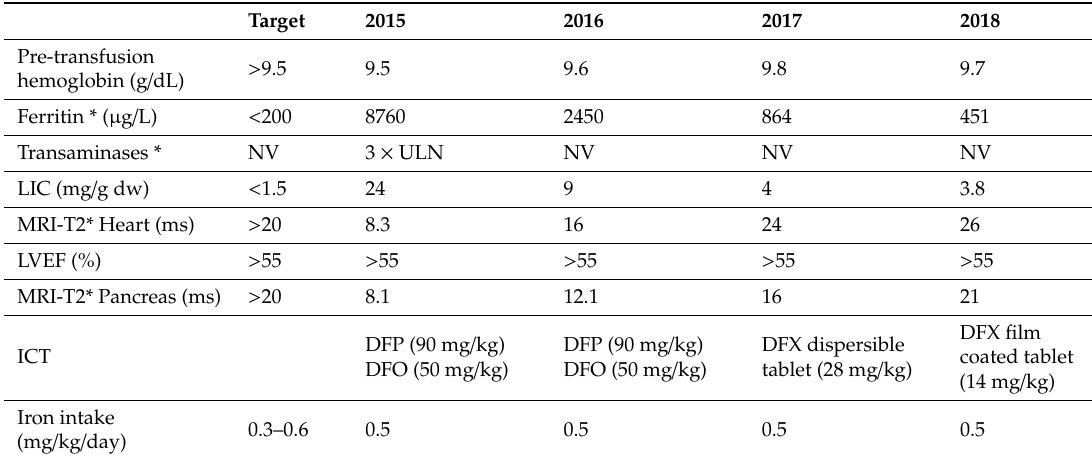
Table 1. Case 1: Characteristics of 19-year-old patient with transfusion-dependent β -thalassemia major with severe multiorgan iron overload